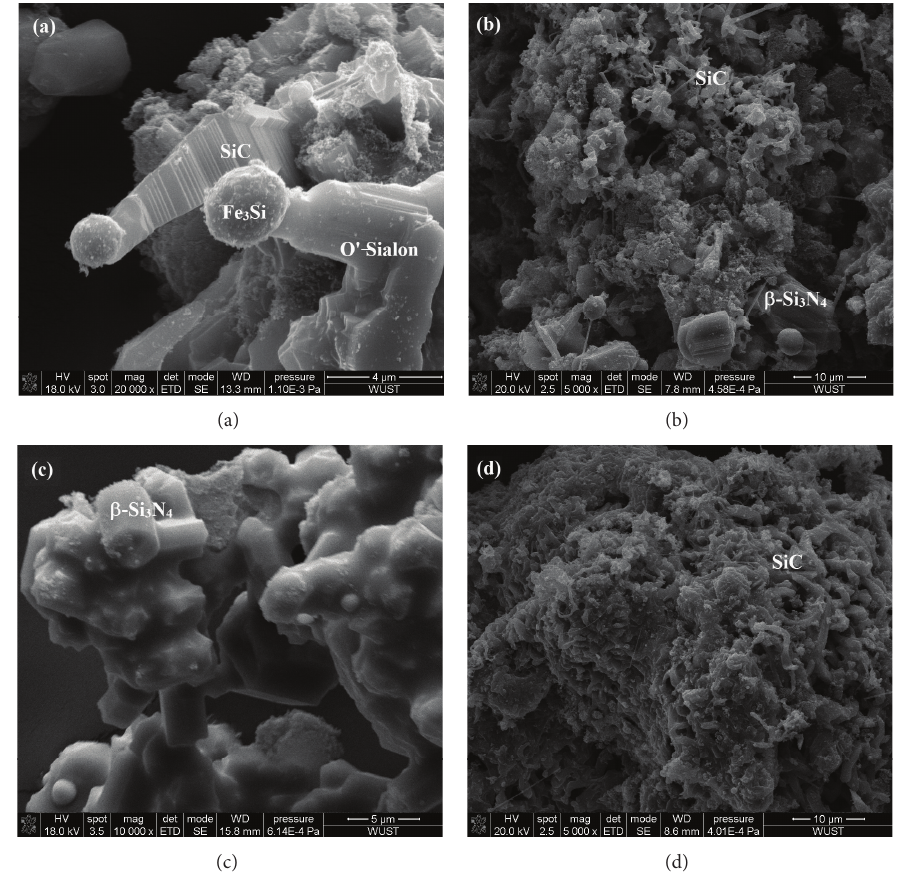
Figure 4: SEM images of sample R3 after calcination at different temperatures for 3 h: (a) 1773 K, (b) 1803 K, (c) 1823 K, and (d) 1853 K.